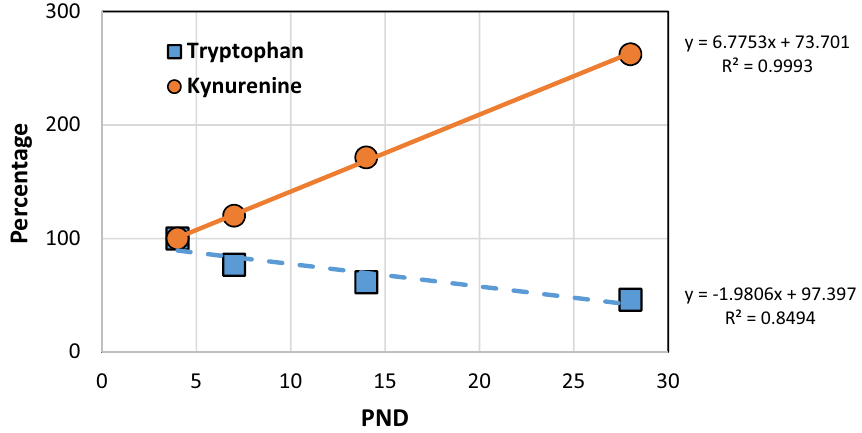
Figure 1. Graphical presentation of tryptophan and kynurenine content in human milk—trend analysis. Data representing content of compounds are percentage of values detected at PND 4. A straight line depicts a trend in the data described by a first order equation (y = ax + b). R 2 is a correlation coefficient value. PND postnatal